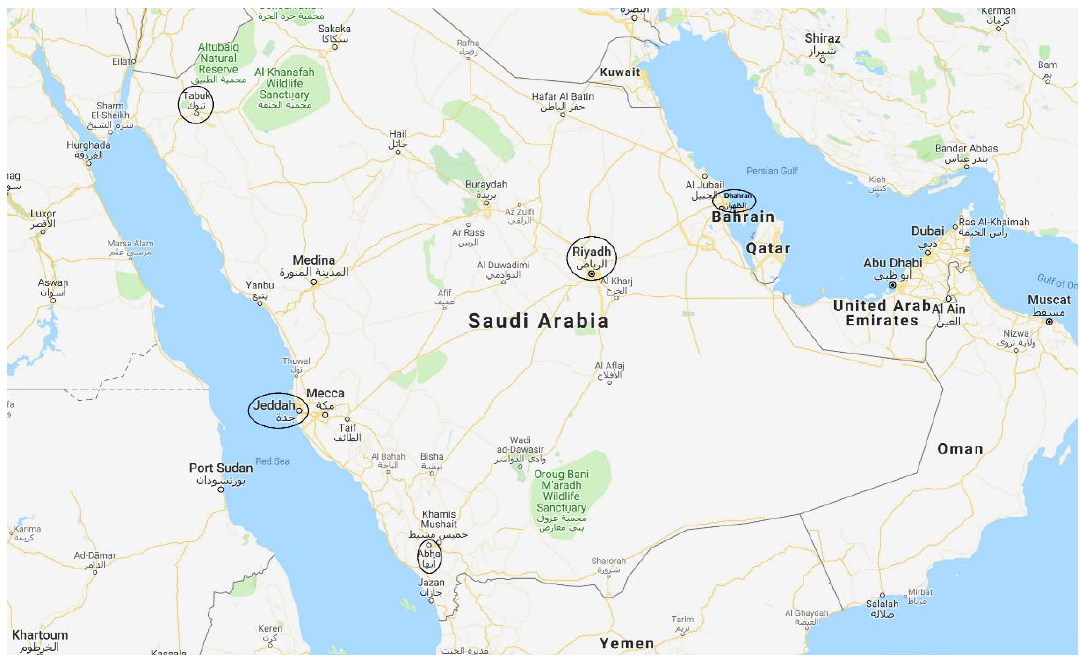
Figure 2. A map of Saudi Arabia showing the locations of the 5 cities.